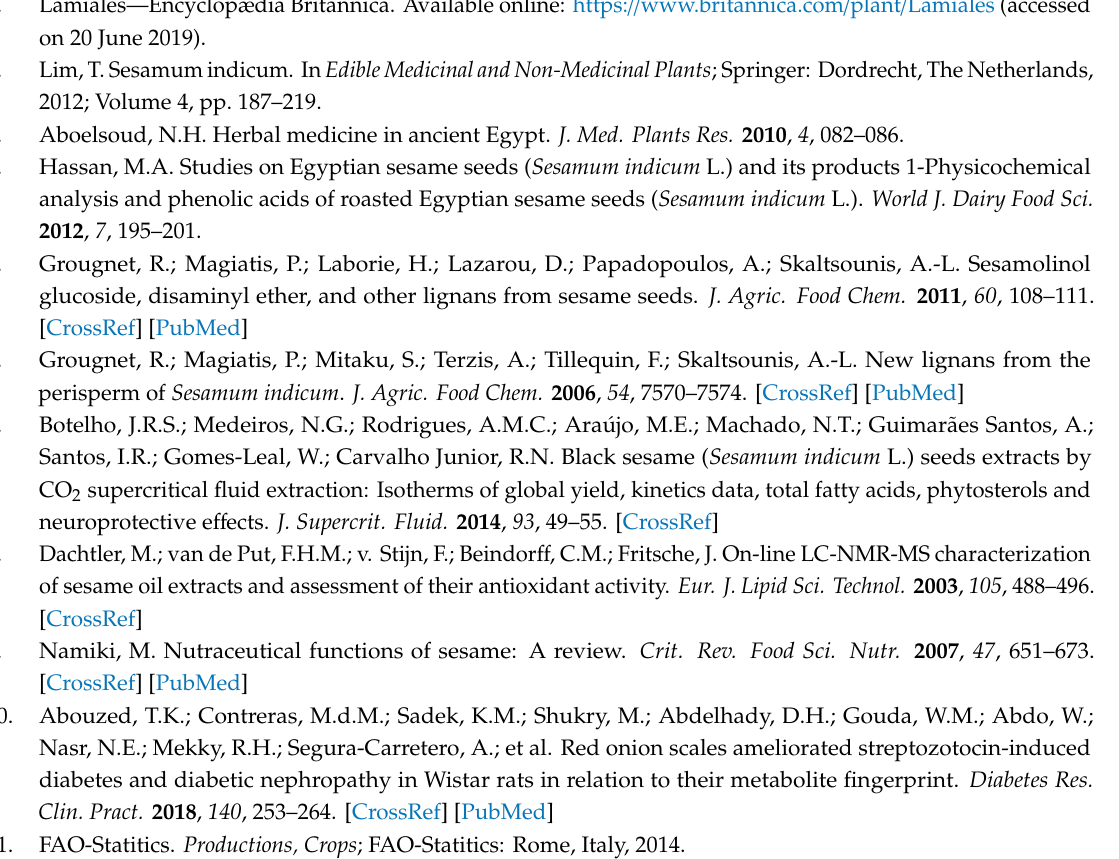
Table S1: Phenolic compounds characterized in the cake of the Egyptian cultivar of sesame ‘Giza 32’, Table S2: Non-phenolic compounds characterized in the cake of the Egyptian cultivar of sesame ‘Giza